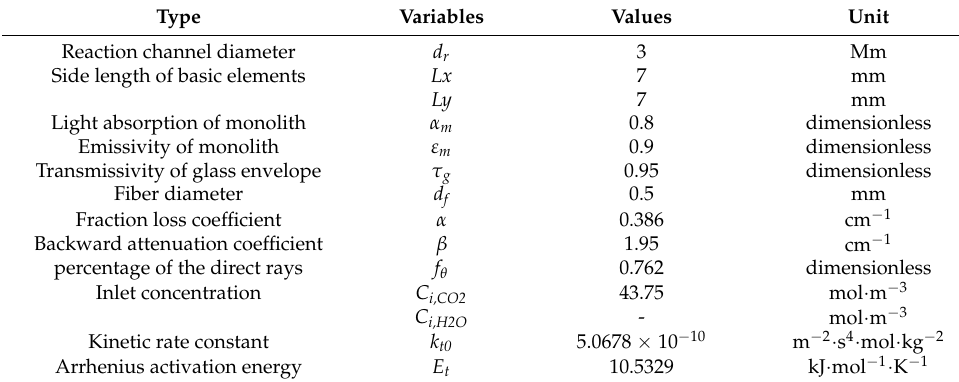
Figure 4. Schematics of the ( a ) monolith area partition and ( b ) a basic element. Table 1. Parameters of the present